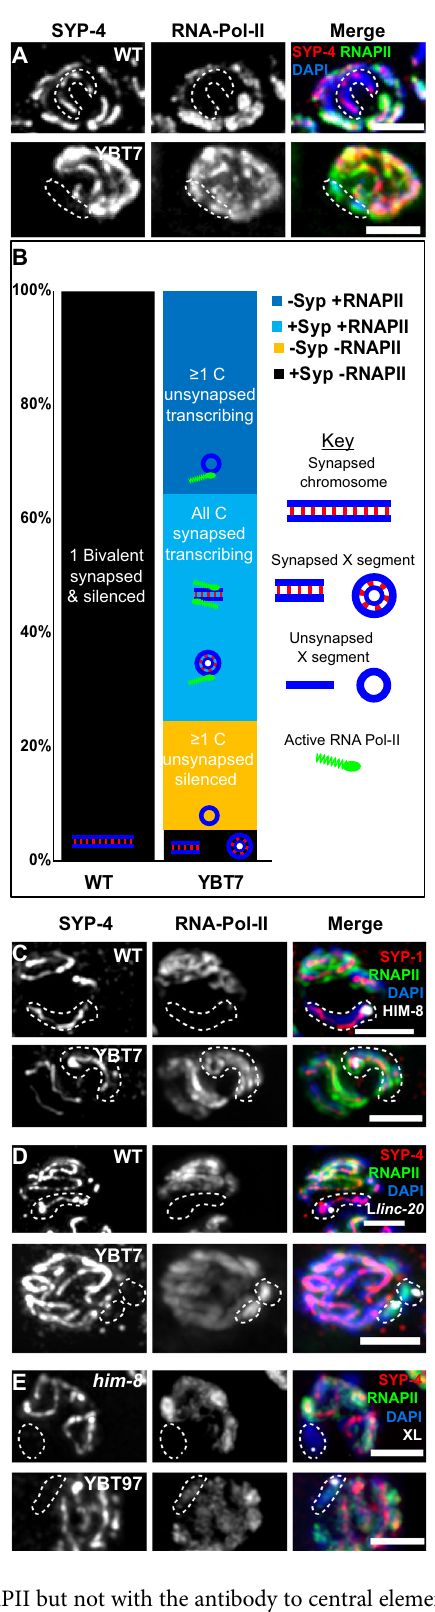
anti-RNAPII but not with the antibody to central element protein SYP-1 were never stained with anti-HIM-8 ( n = 30, Fig. 7C). This shows that these unsynapsed active segments are not the linear segment of the X. When we used the FISH probe directed to the left of the linc-20 locus, we found that the internal segment was marked with SYP-4 in some cases. More importantly, we detected